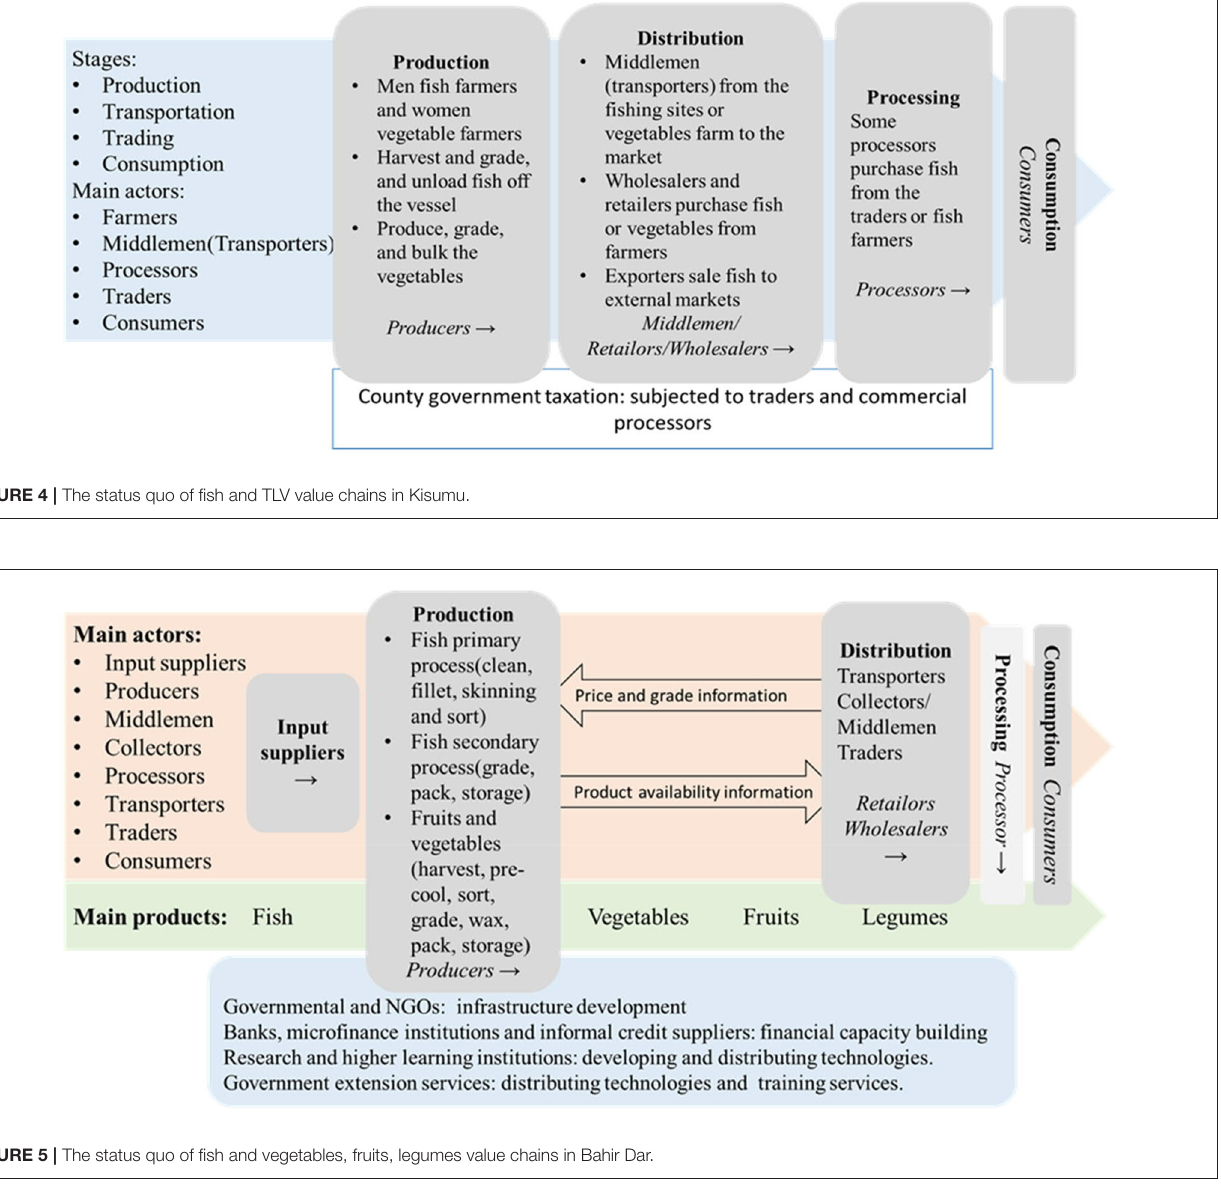
of fish and vegetables, fruits, legumes value chains is shown in Figure 5